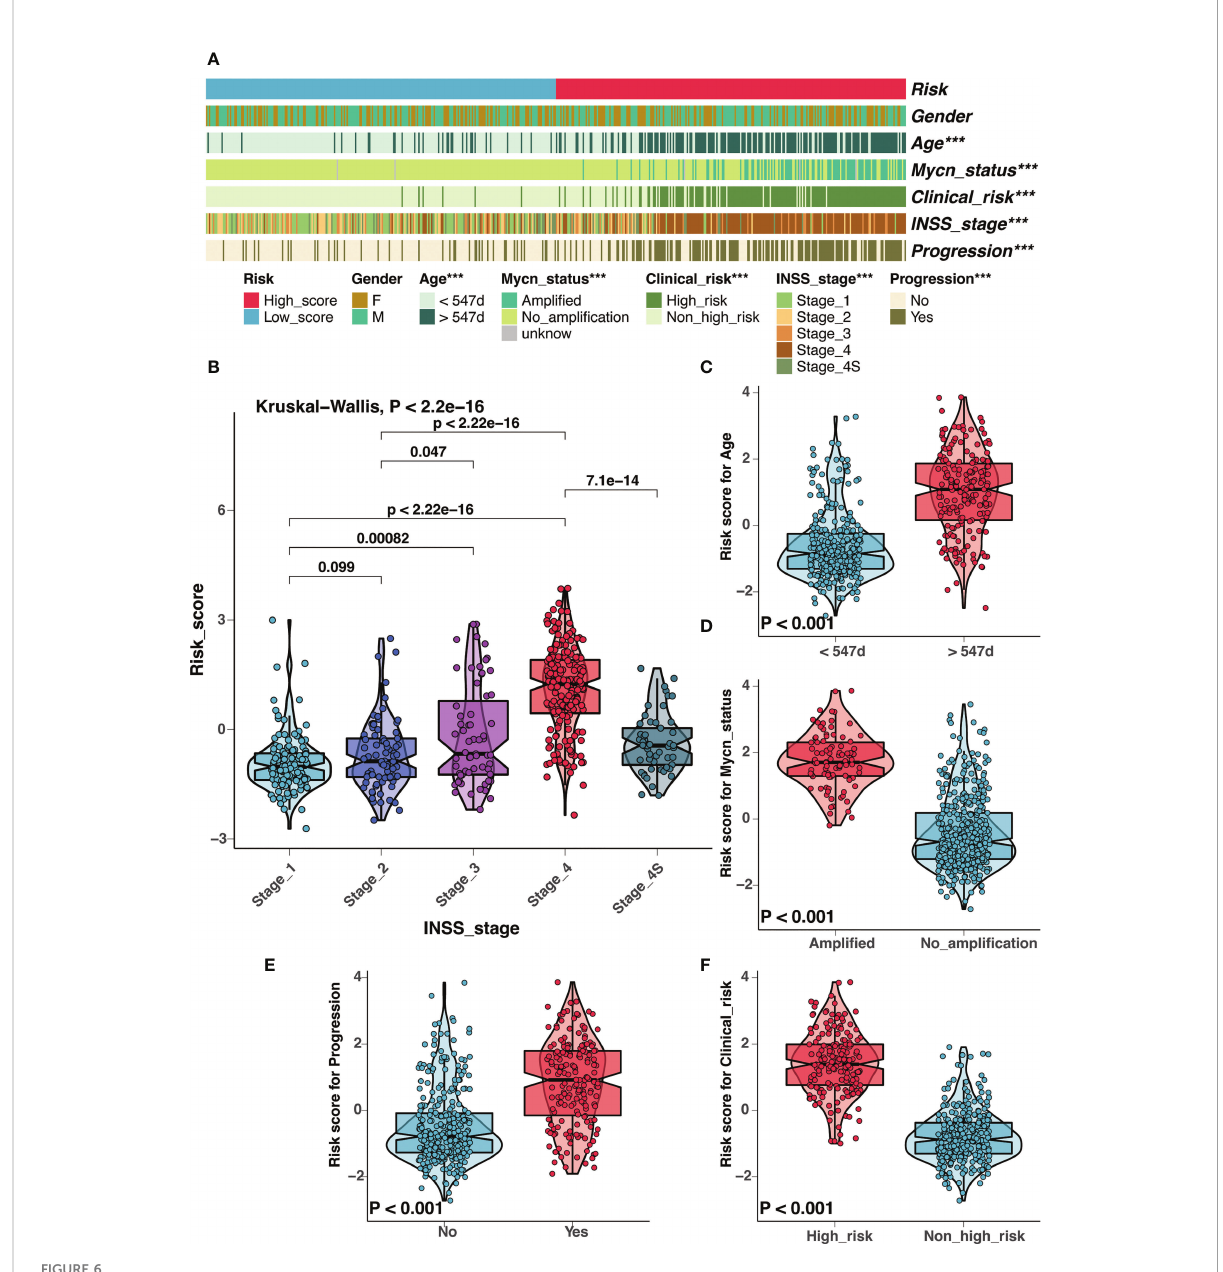
FIGURE 6 Correlation analysis between clinical characteristics and the risk signature in GSE49710 cohort. (A) Correlation analysis between the risk signature and clinical characteristics in GSE49710 cohort. (B-F) The comparison of risk scores between samples with different clinical characteristics, including INSS stage (B) , age (C) , MYCN status (D) , progression (E) , and COG risk groups (F) . (***: P <